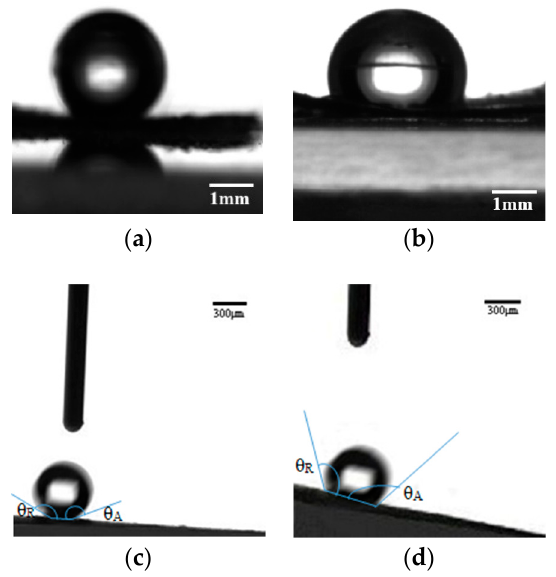
Figure 7. Wettability of the surfaces of the mesh membranes; water droplets on: ( a , c ) parabolic morphology; ( b , d ) truncated cone morphology.